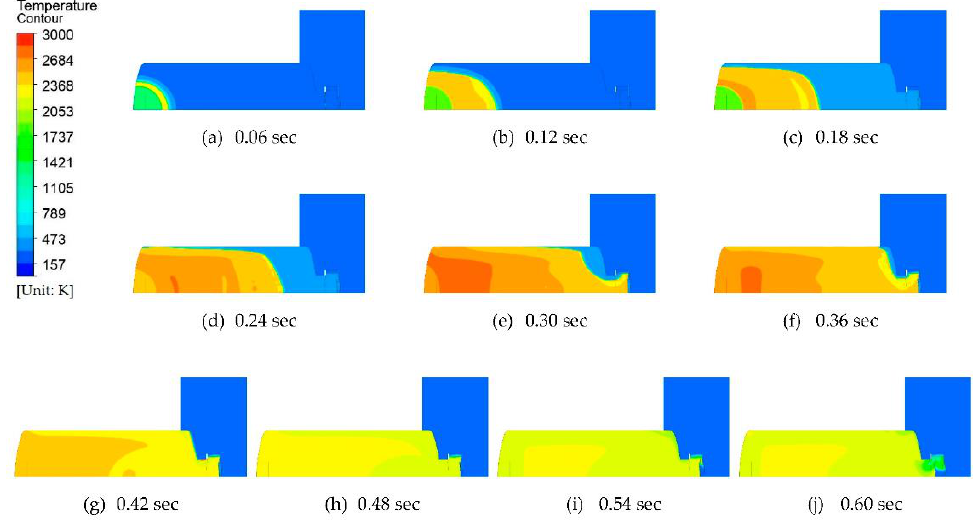
Figure 3. Temperature contour results after the explosion.